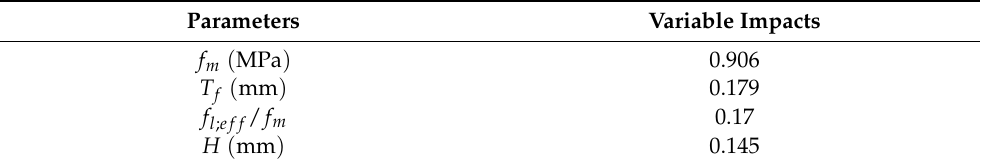
Table 5. Parameters and their impact in the simplified symbolic expression model.